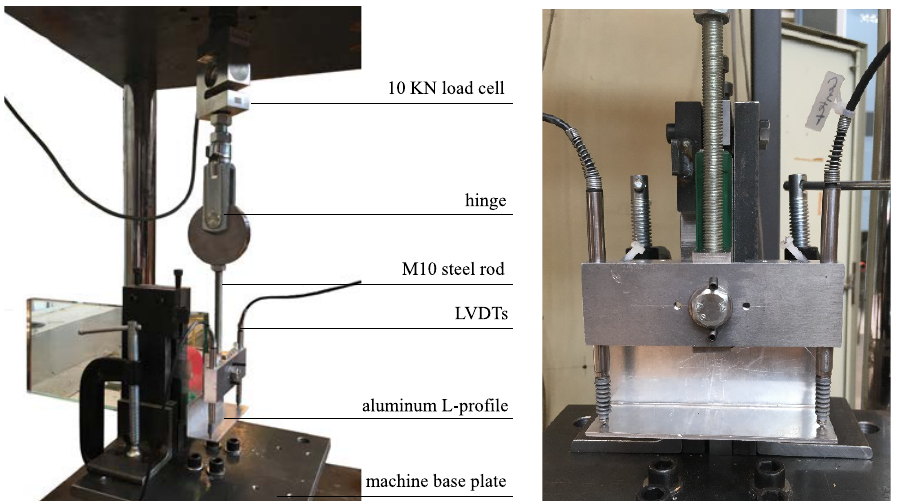
Fig. 7 Set-up for shear testing the TSSA edge bonded connections (left) and method for measuring the relative displacement of glass and steel (right)